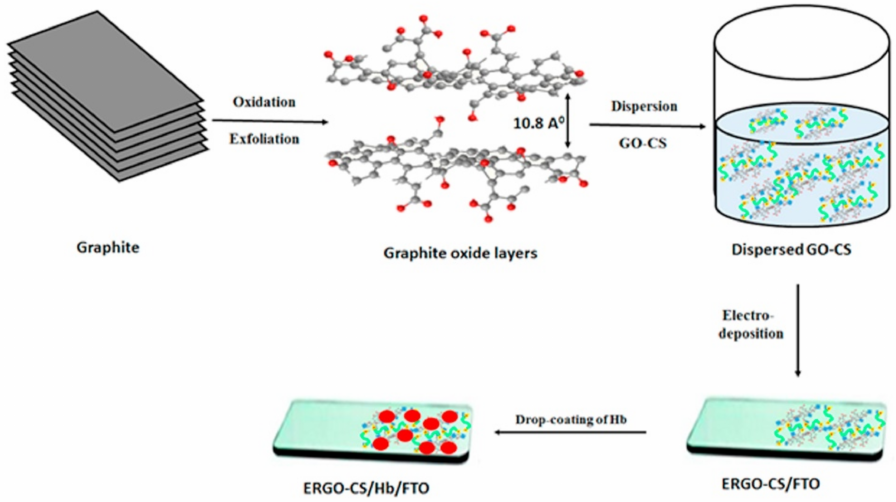
Figure 9. Scheme of the methyl parathion sensor assembling steps. Reprinted with the permission from reference [104]. Copyright 2020